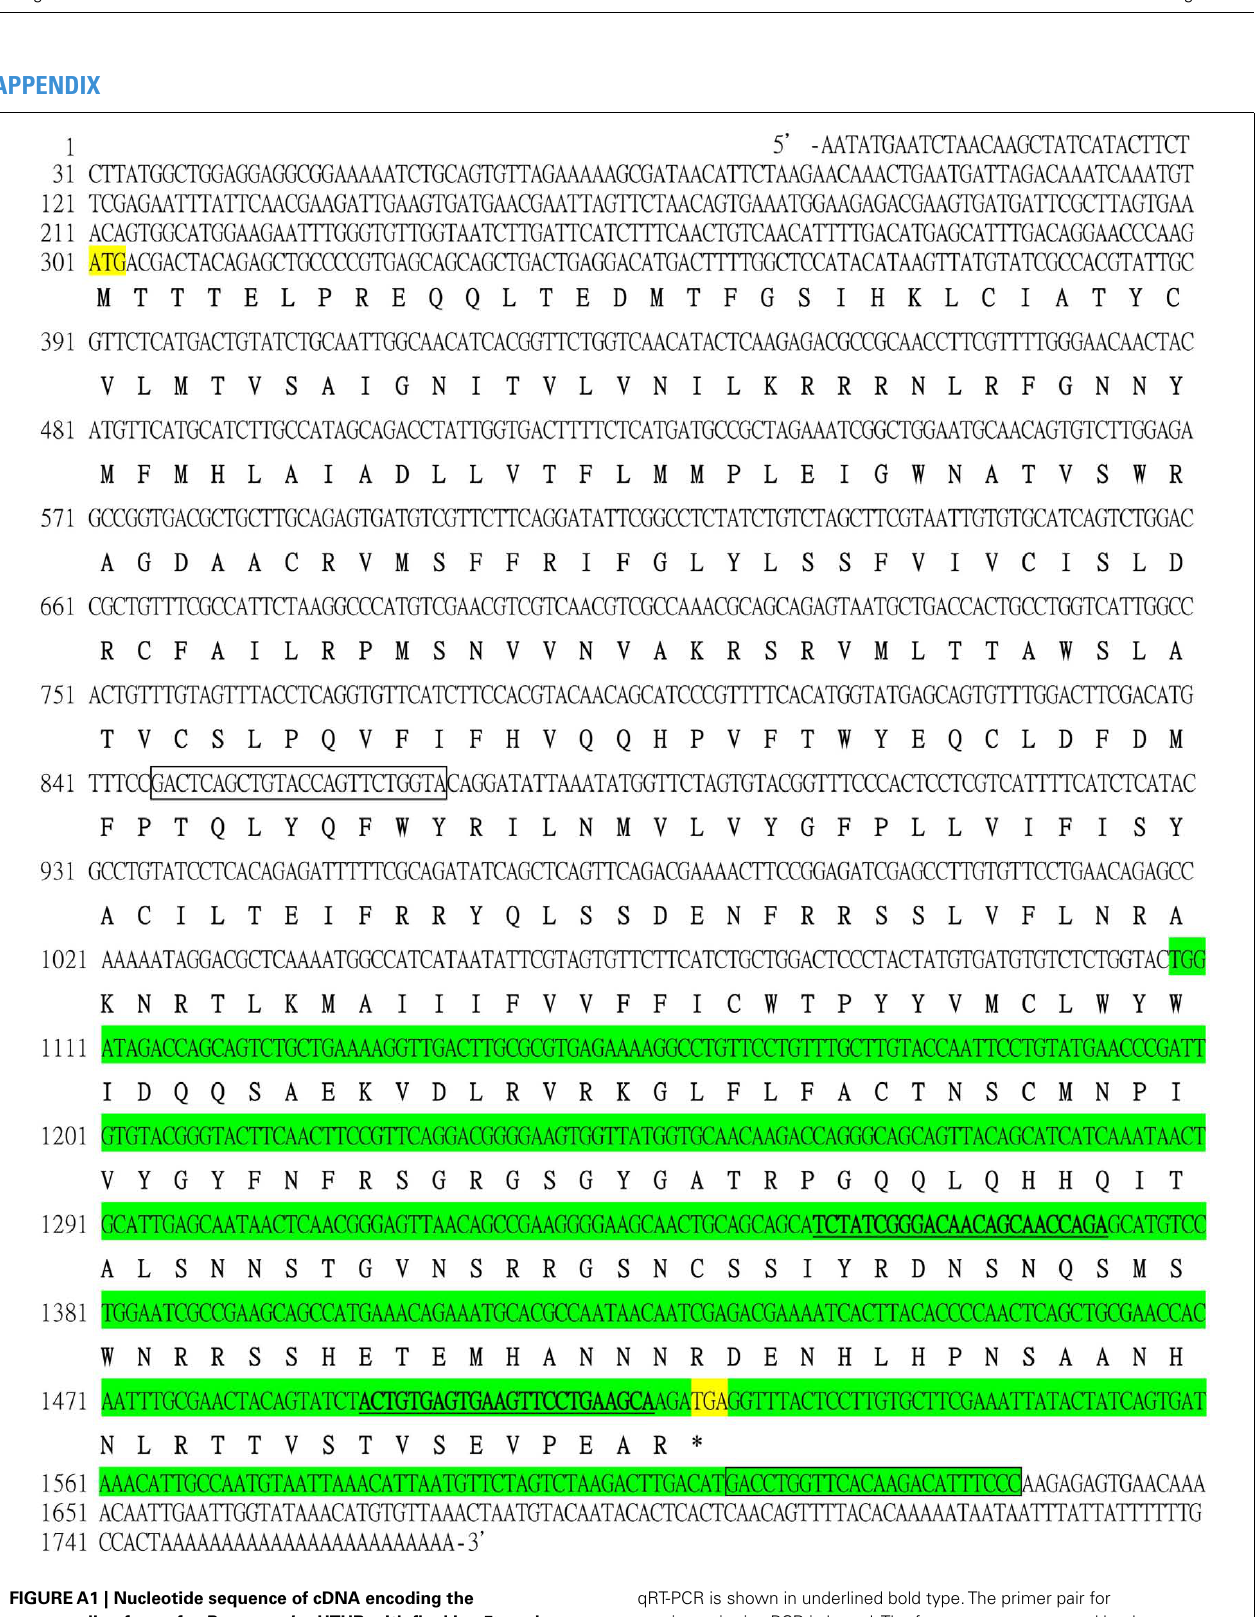
qRT-PCR is shown in underlined bold type.The primer pair for semiquantitative PCR is boxed.The fragment encompassed by the dsHTHR used in the RNAi experiments is shown in green